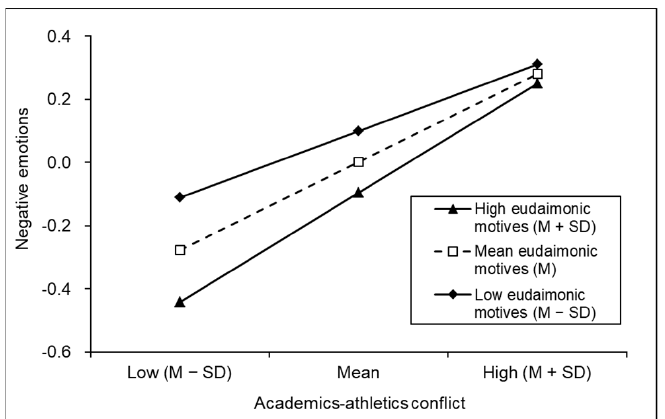
Figure 3. Simple slope diagram of the relationship between academics–athletics conflict and nega- tive emotions mediated by eudaimonic motives.